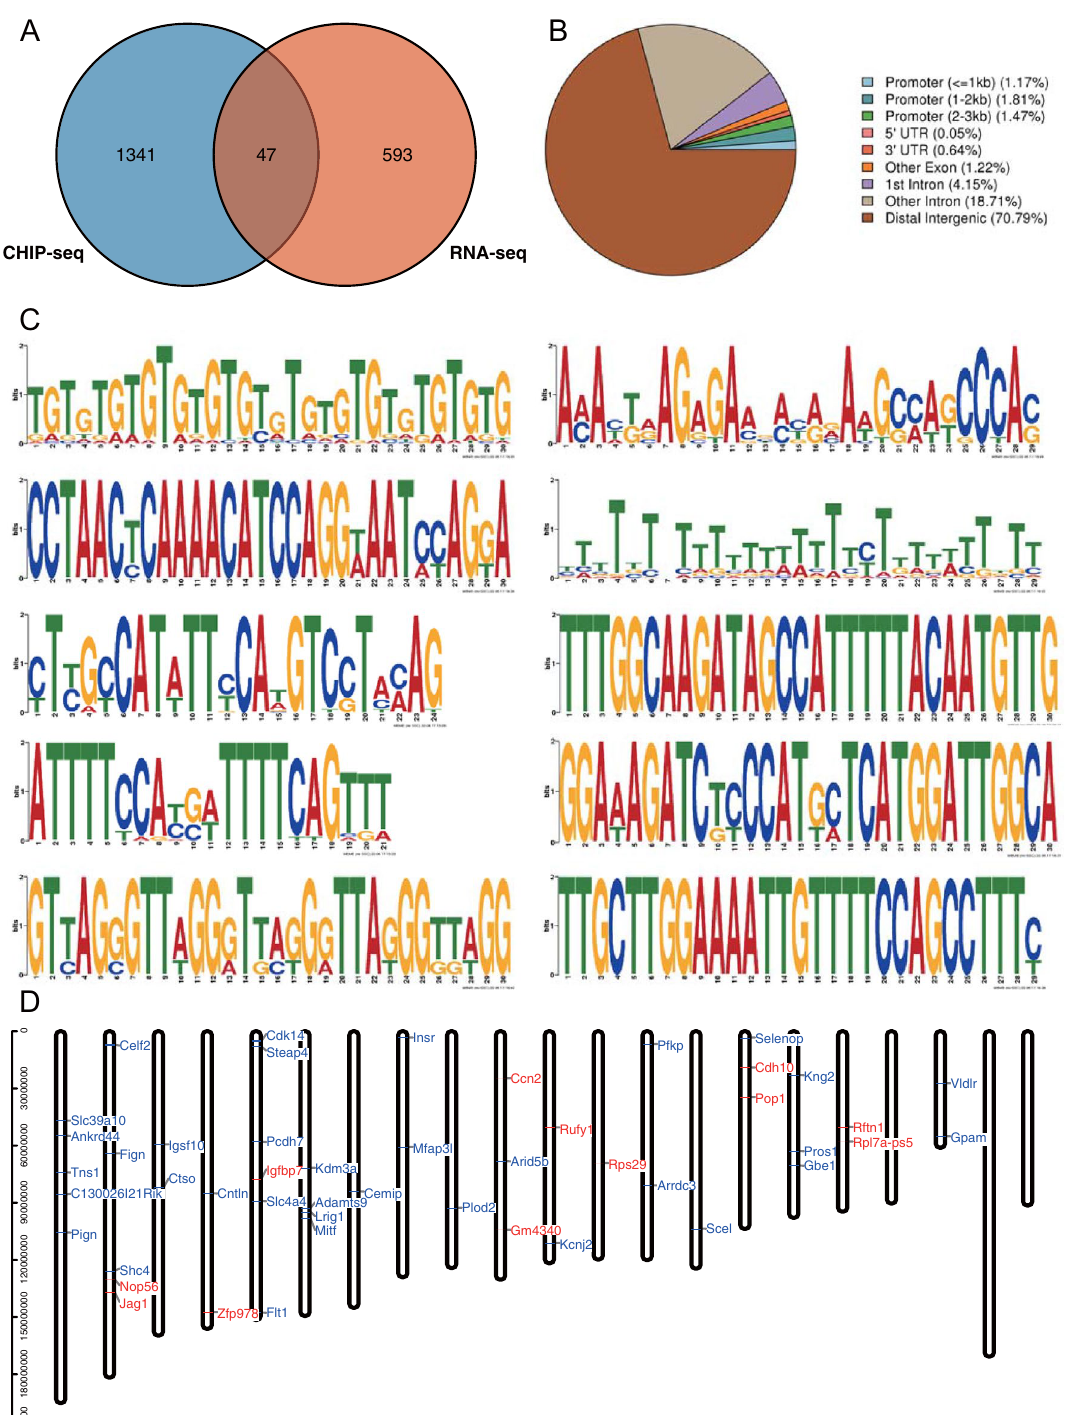
Figure 4. ChIP-seq analysis. ( A ) ChIP-seq detected a total of 1388 genes likely to bind to Purα. Compared with 656 differential genes obtained by RNA-seq, a total of 47 genes were obtained. ( B ) Peak region annotation classification of Purα-bound DNA. ( C ) ChIP-seq analysis yields a total of 10 motifs with which Purα may bind, and the logos are sorted in order. ( D ) The position and expression of the 47 genes obtained from A on the chromosome. The blue represents gene down-regulation and the red represents